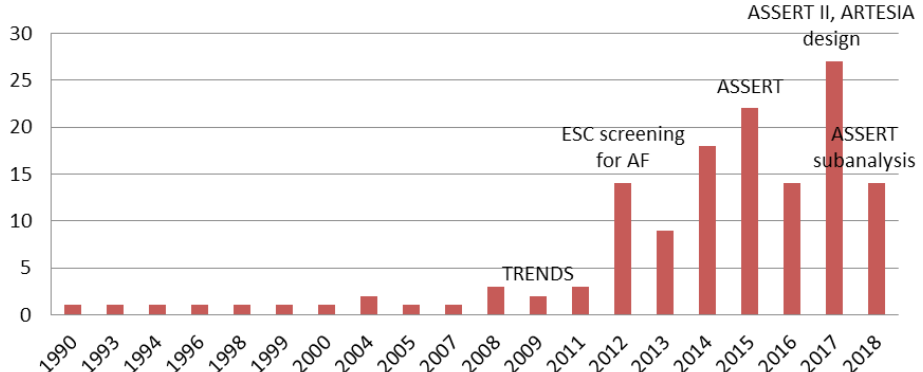
Fig. 2. Evolution of the number of publications with indication of the milestone studies of sub- clinical atrial fibrillation and its association with stroke as documented by Medline database; best match search – keywords in the